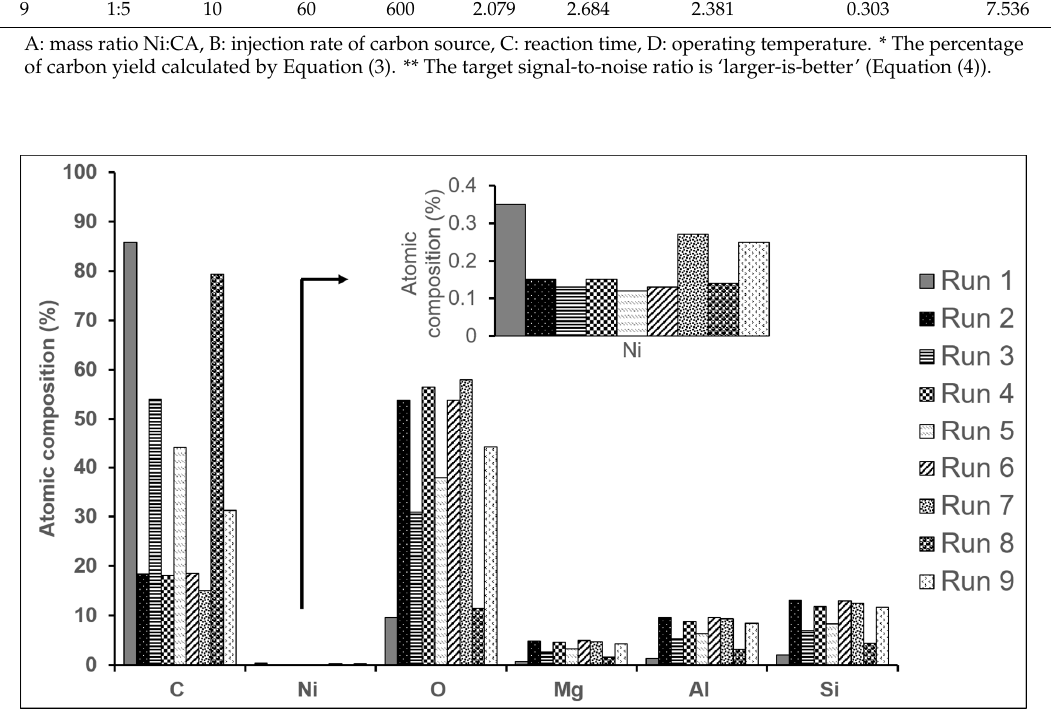
Figure 2. Energy-dispersive X-ray spectroscopy (EDX) of CNT monolith for each run of the Taguchi-based design.